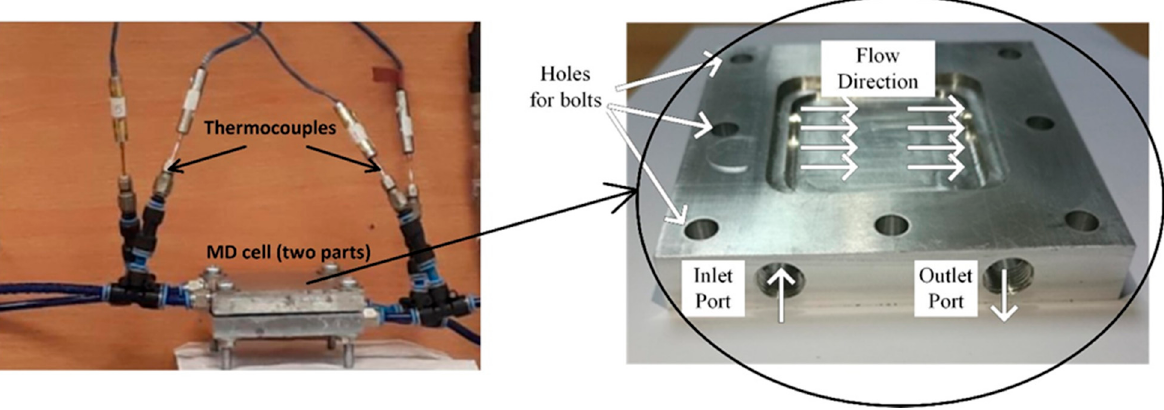
Figure 2. Experimental membrane distillation test rig.